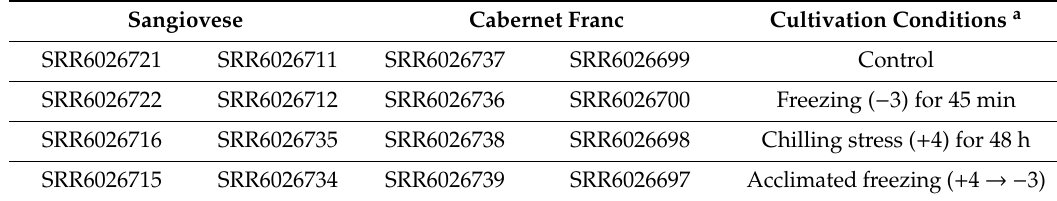
Table 3. RNAseq libraries of Vitis vinifera cultivated under cold stress [37].